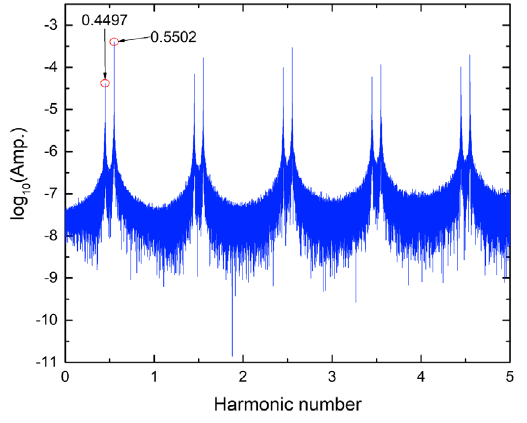
FIG. 13. Betatron sidebands in the vertical direction. The ( 1 − Q ) line is also clearly dominant and the lower betatron sidebands also grow more than the upper